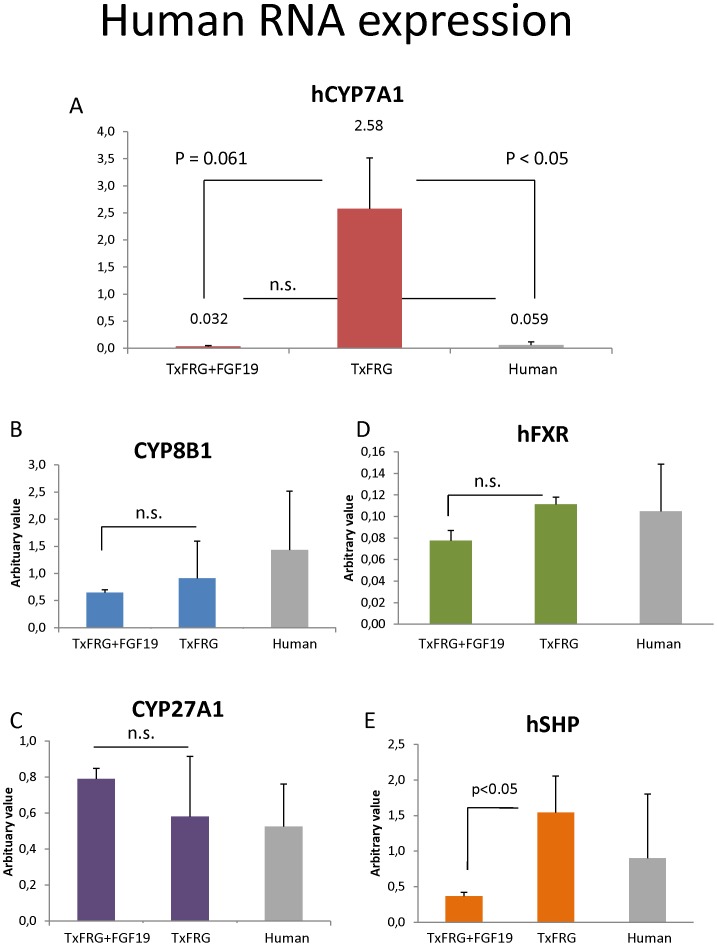
Expression of human RNA.A, Expression of human CYP7A1 in humanized FRG mice (TxFRG) treated with FGF19 (TxFRG+FGF19) compared to human control. Statistics were performed by a non-parametric Kruskal-Wallis ANOVA. The overall significance of the experiment was p<0.05. Expression of human CYP8B1 (B), CYP27A1(C), FXR (D) and SHP (E) in livers of humanized mice (TxFRG) treated with FGF19 (TxFRG+FGF19). Human liver RNA was used for reference (n = 9).